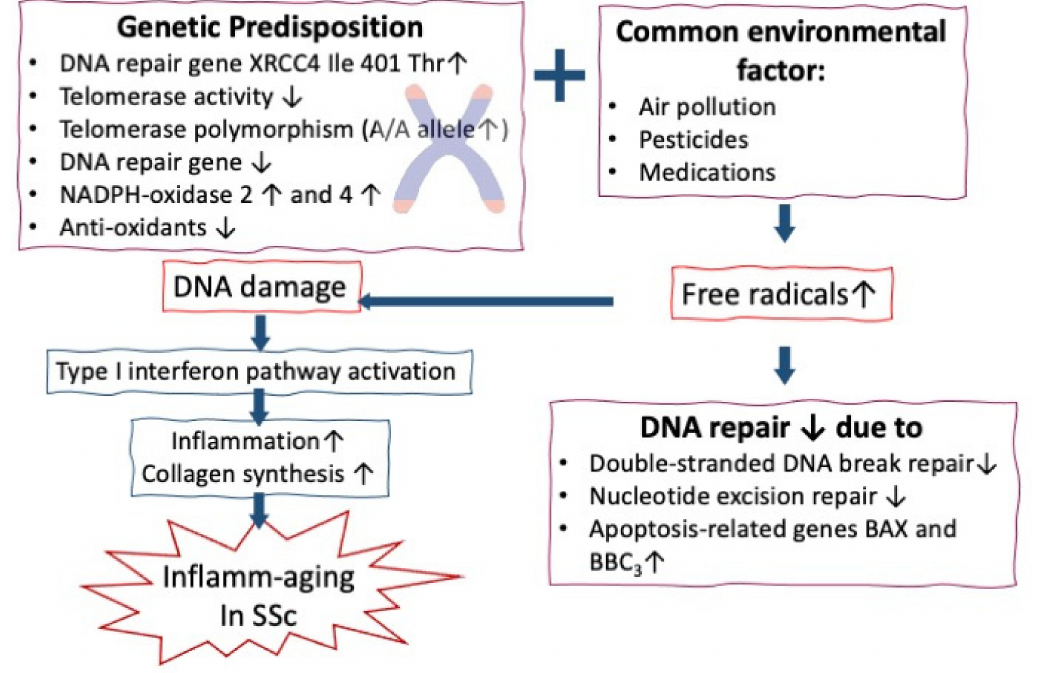
Figure 5. The genetic defects containing the DNA repair gene, telomerase activity, redox genes, and anti-oxidant